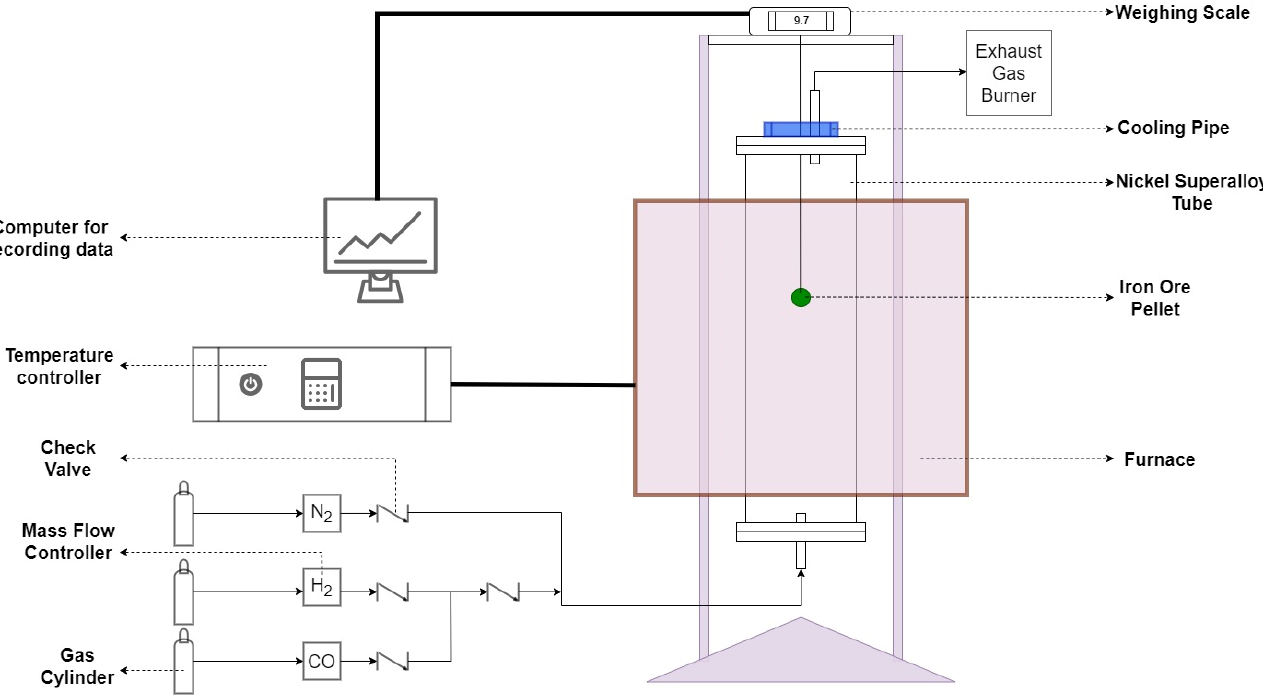
Figure 2. Schematic of the experimental setup for iron ore pellet reduction.